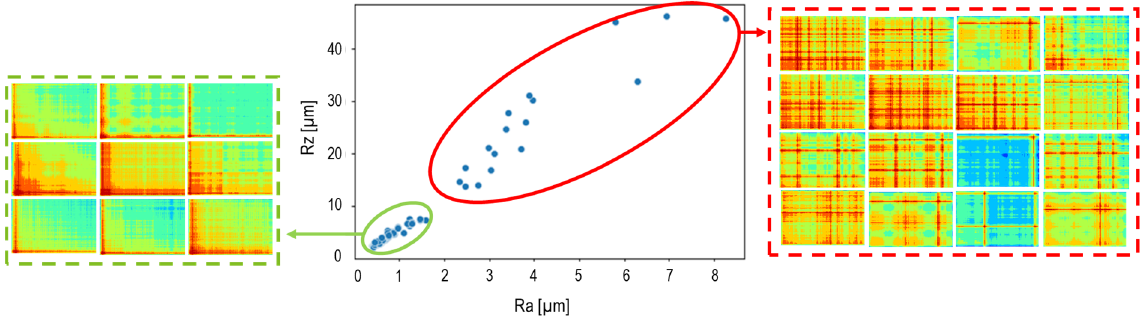
Figure 11. Surface roughness values and some exemplary GASF images.